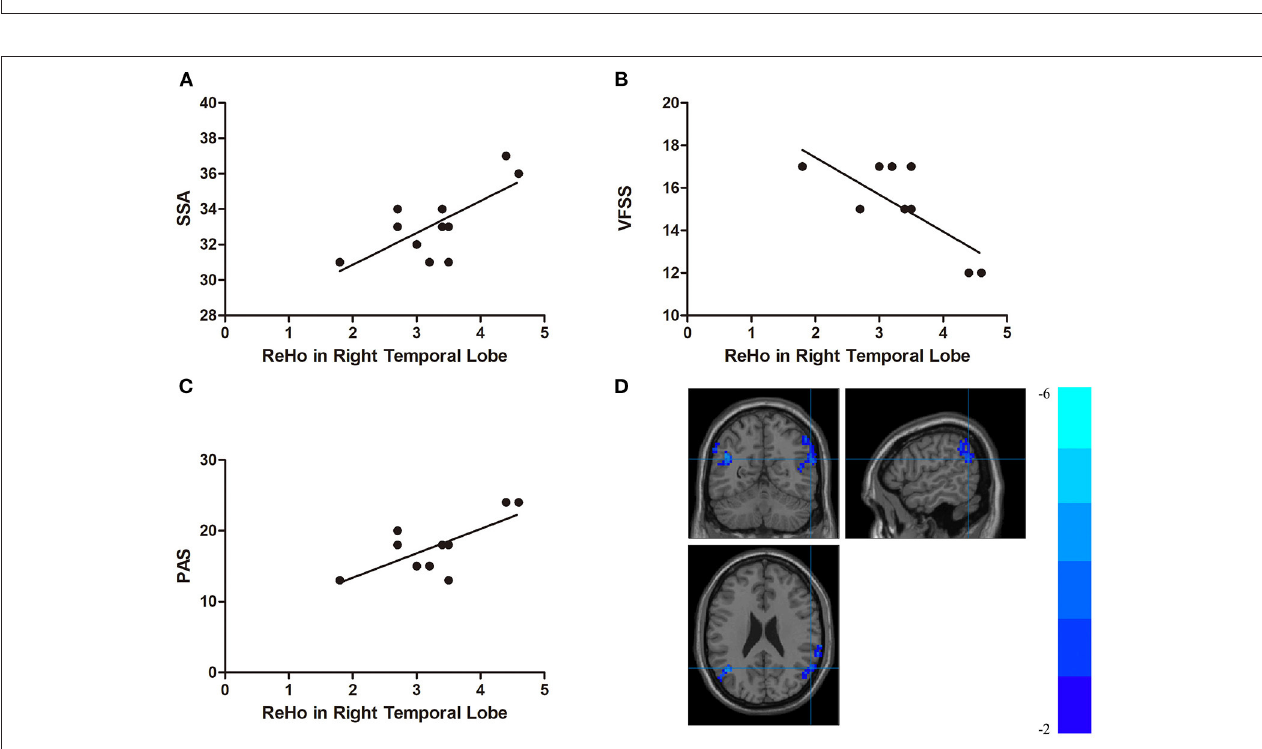
FIGURE 4 | (A) Correlations between the Standardized Bedside Swallowing Assessment (SSA) score and regional homogeneity (ReHo) in the right temporal lobe; (B) Correlations between the Videofluoroscopic Swallowing Study (VFSS) score and decreased ReHo in the right temporal lobe; (C) Correlations between the Penetration-Aspiration Scale (PAS) and decreased ReHo in the right temporal lobe; (D) Regions exhibited in the right temporal lobe [ p < 0.001 corrected by the Gaussian random field (GRF)].